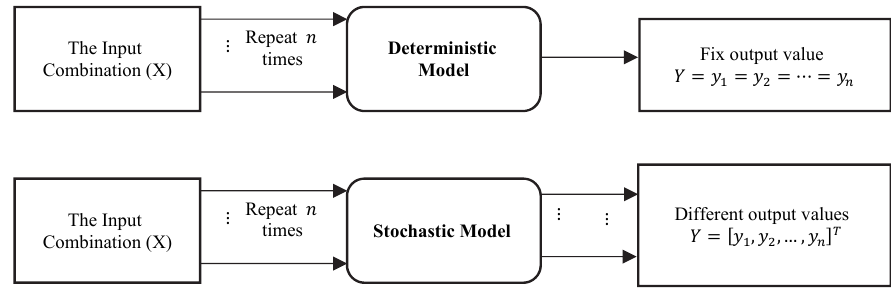
Fig. 5. Deterministic and stochastic simulation